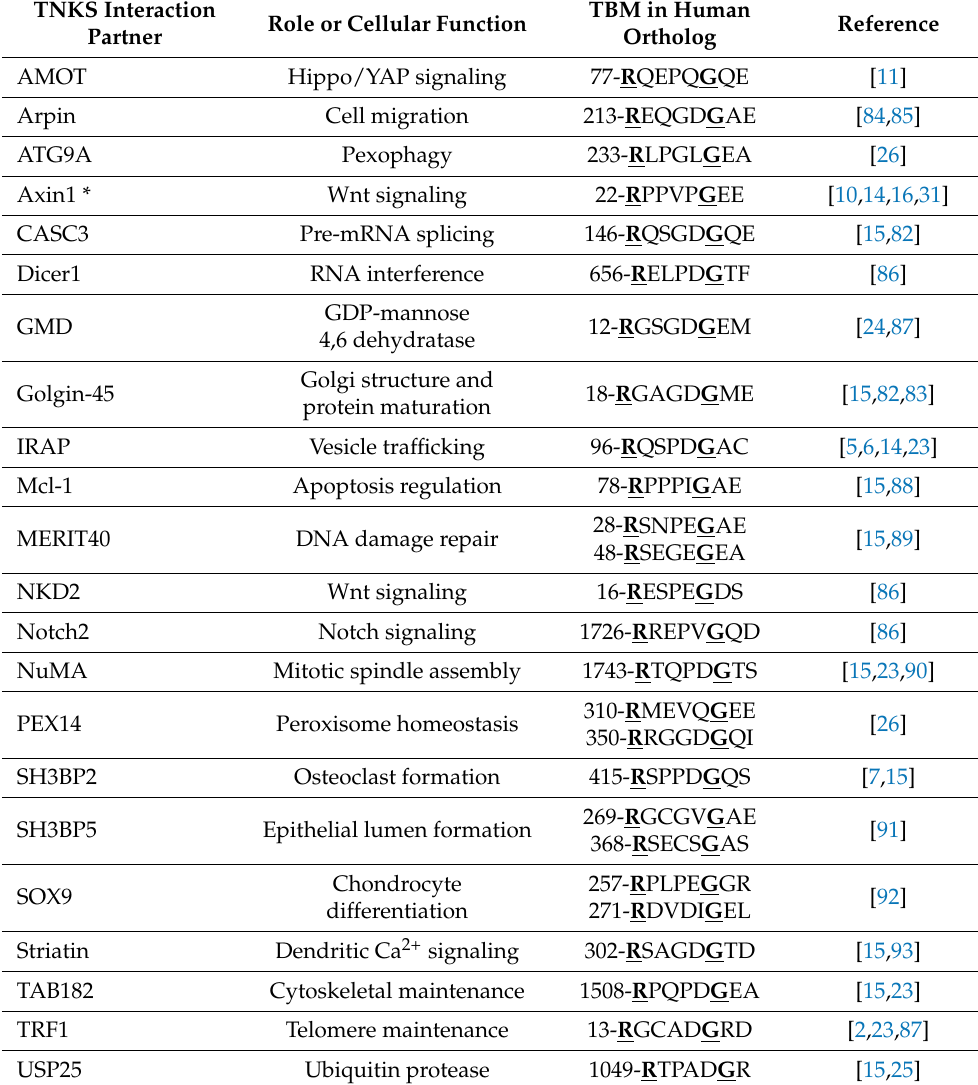
Table 2. Overview of tankyrase interaction partners used for the analysis. The required arginine and glycine in each TBM is shown in bold and underlined. The residue number of the arginine in the first position of the TBM from the human ortholog is